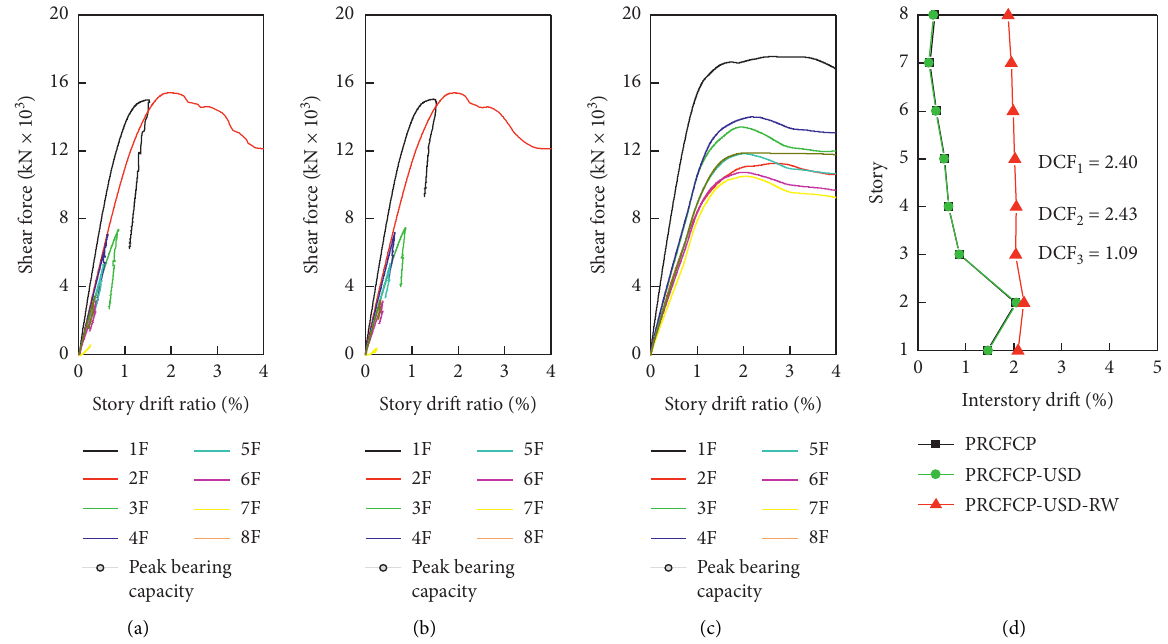
Figure 9: Interstorey shear force and interstorey drift curves of the frame. (a) PRCFCP. (b) PRCFCP -USD. (c) PRCFCP -USD-RW. (d) Inter-storey drift.